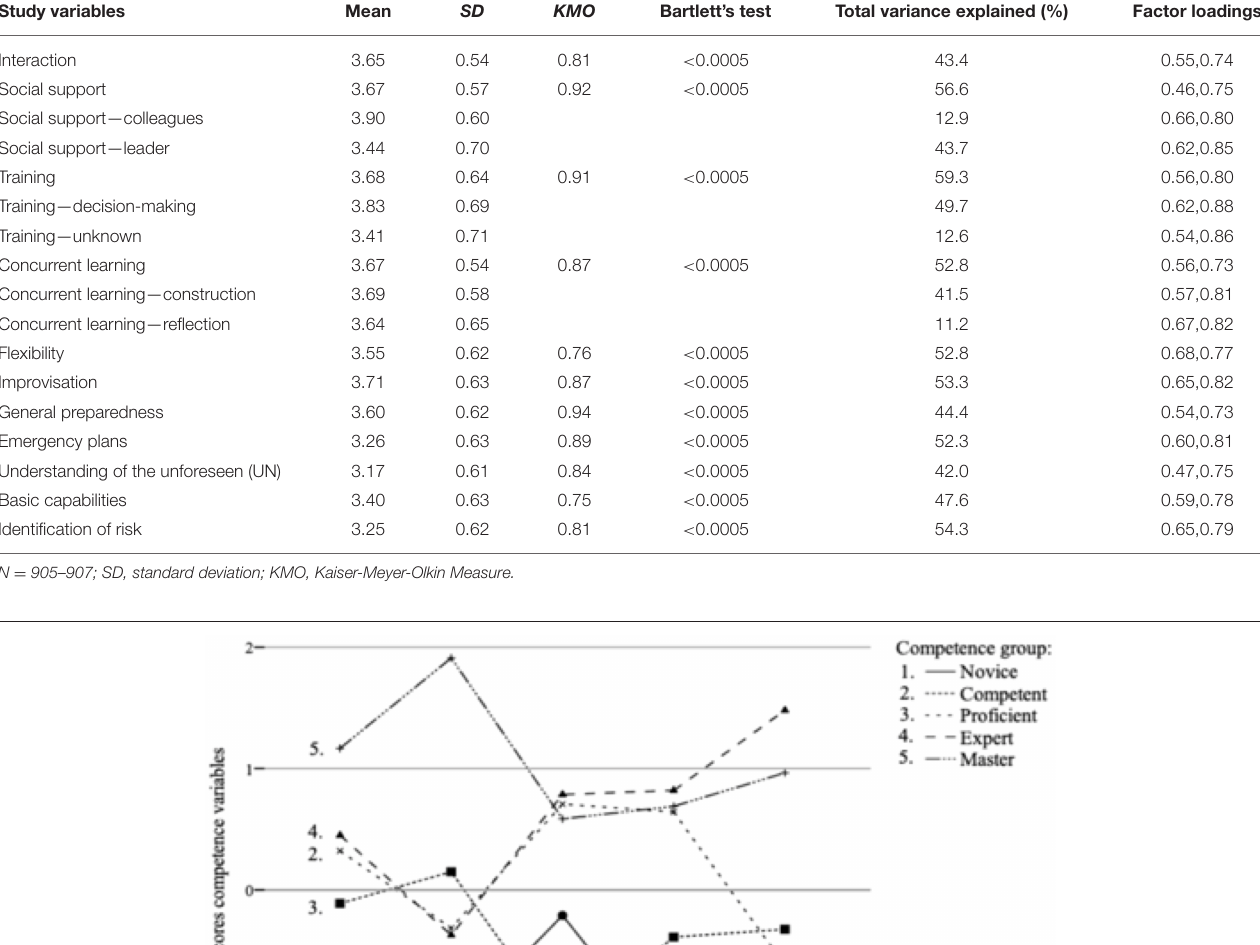
TABLE 2 | Mean, standard deviation, Kaiser-Meyer-Olkin Measure, Bartlett‘s test, total variance explained, and factor loadings for the study variables. Study variables